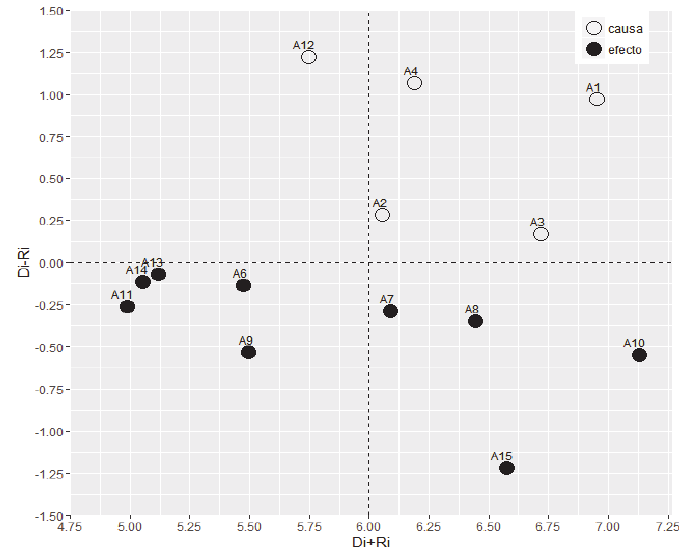
Fig. 3. Cause and effect diagram of the influence of technological